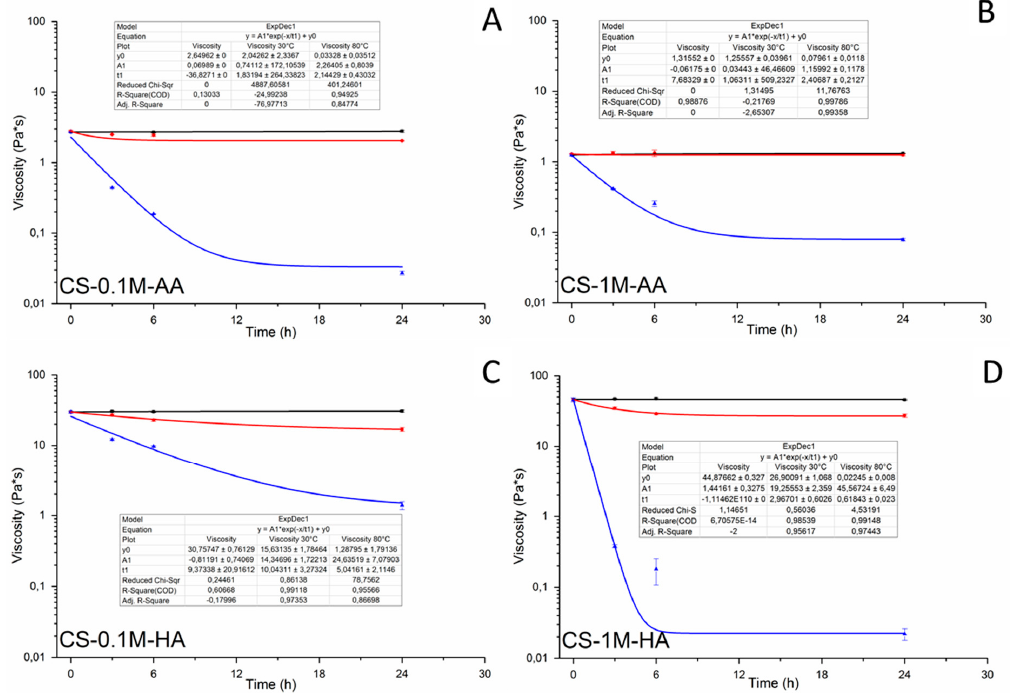
Figure 2. Viscosity of the different sample solutions stored for different time points at 4 °C ( square ), 30 °C ( circle ) and 80 °C ( triangle ). Please note that some symbols overlap the standard deviation bars. ( A ) CS-0.1M-AA; ( B ) CS-1M-AA; ( C ) CS-0.1M-HA ; ( D )